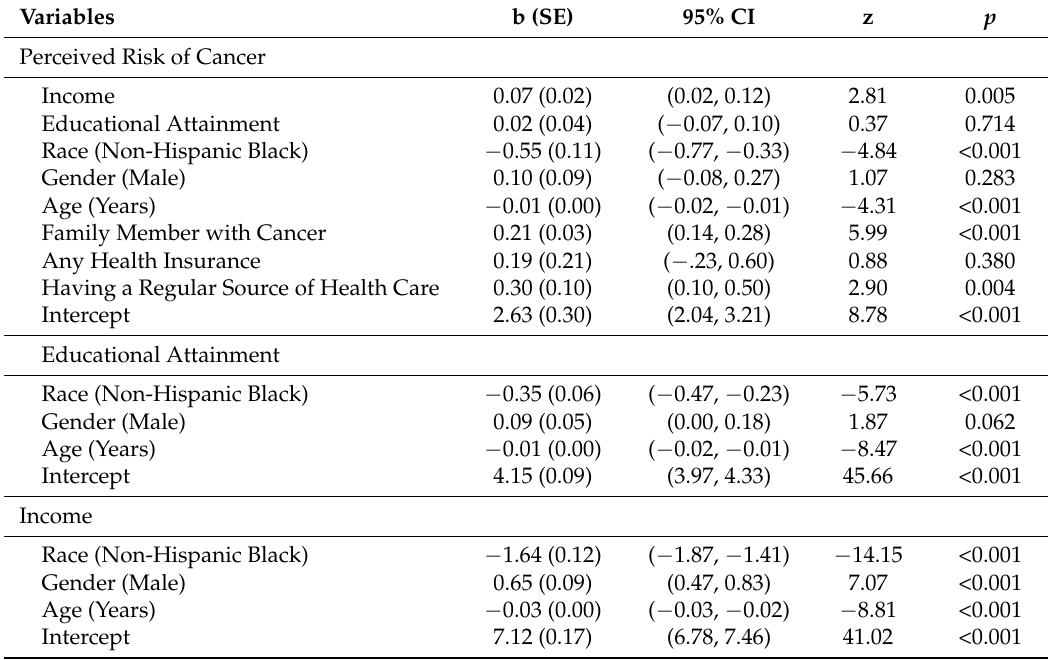
Table 4. The associations between race, socioeconomic status (SES; educational attainment and income), and perceived risk of cancer in a nationally representative sample of American